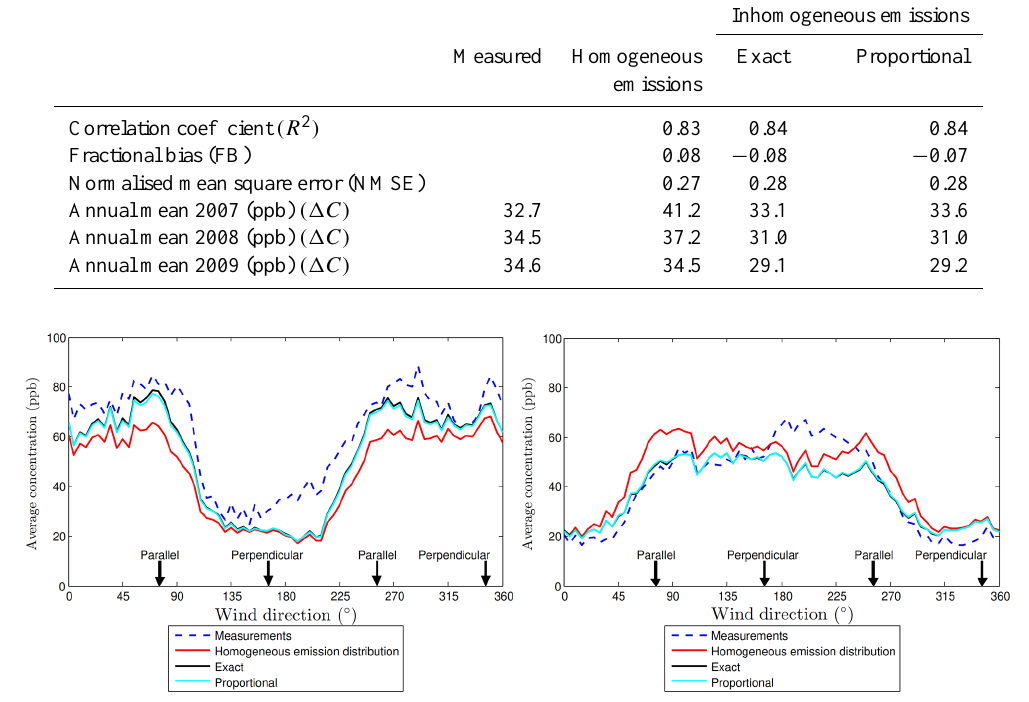
horizontal dispersion has to be implemented in the